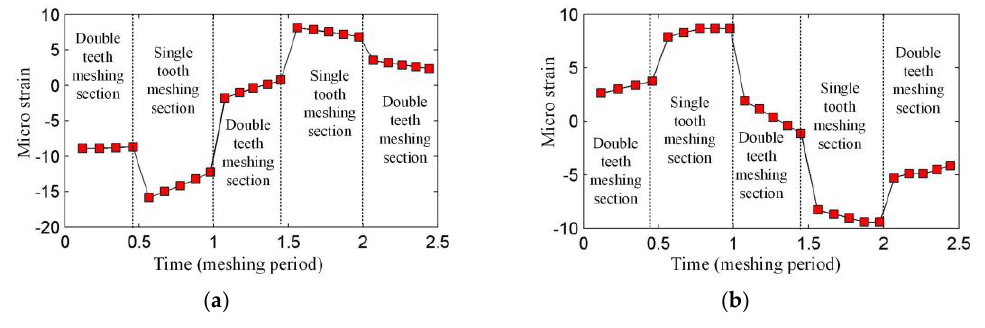
Figure 9. Average strains along ( a ) FBG1 and ( b ) FBG2.